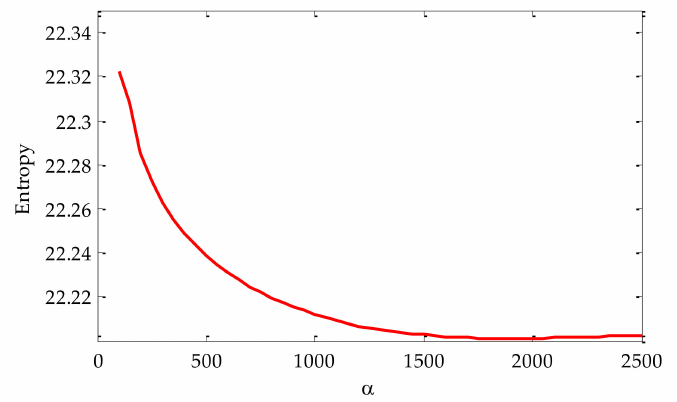
Figure 38. Curve of fitness varying with a